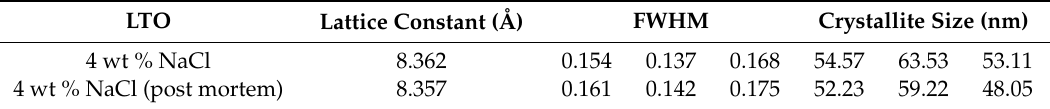
Table 4. The structural parameters of LTO material before and after cycling.